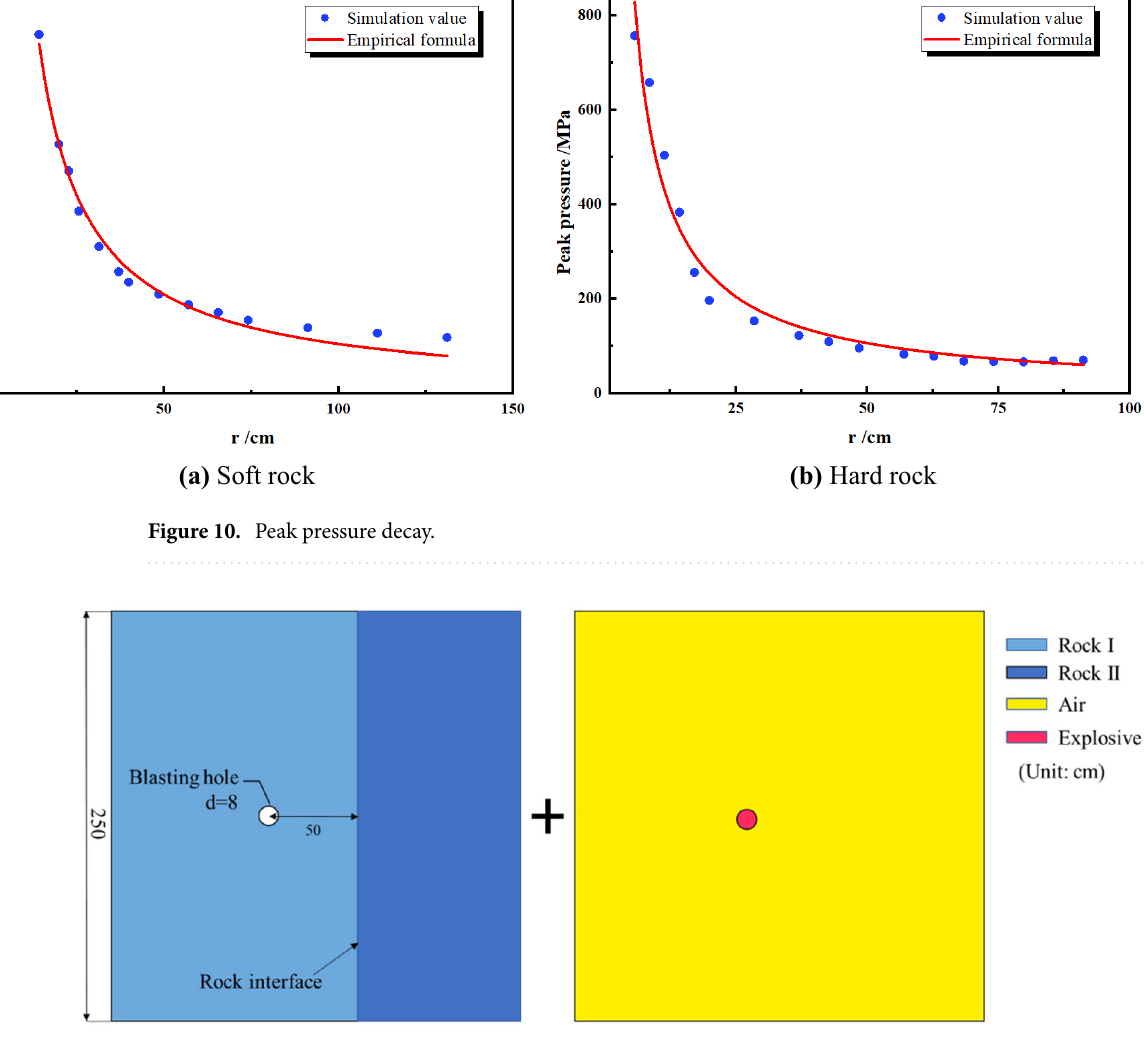
Figure 11. 2D model of single-hole blasting in composite rock